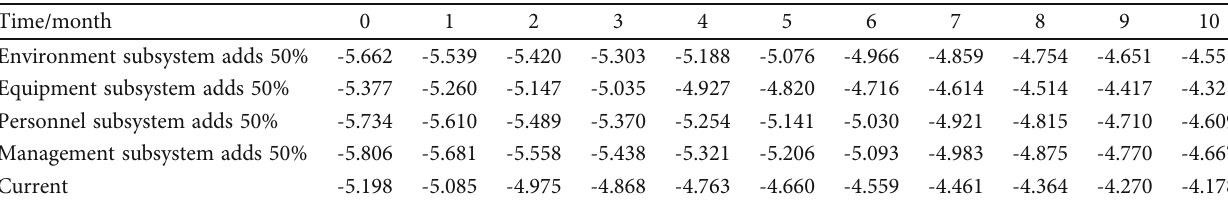
Table 6: Simulation results of exposure variation.